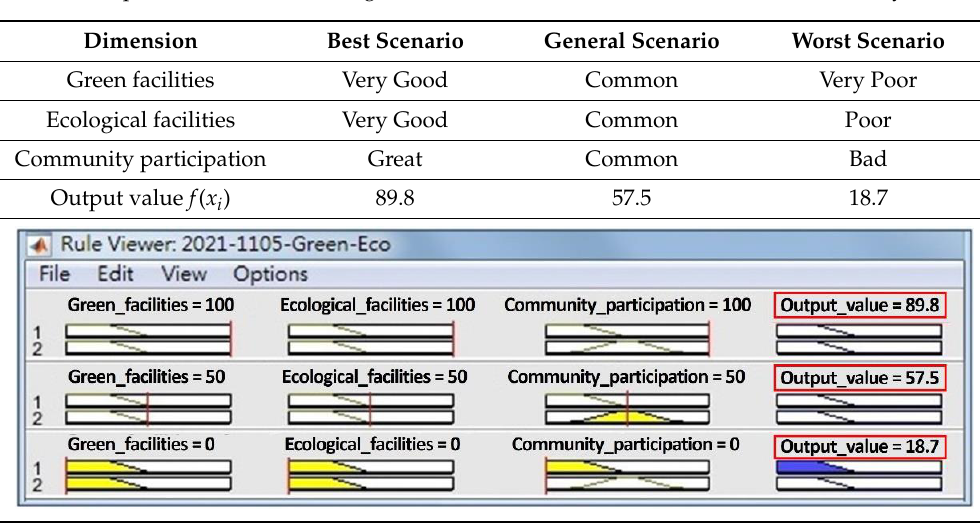
Table 8. Output values of best, average, and worst cases of each dimension in the DAFuzzy model.